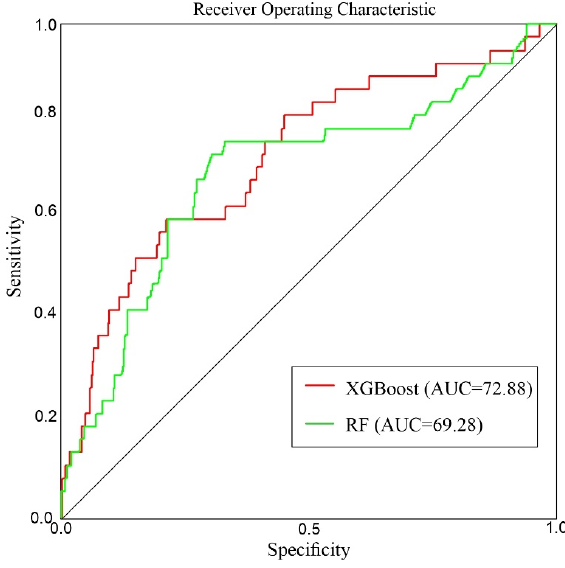
Figure 10. ROC plots of XGBoost and RF